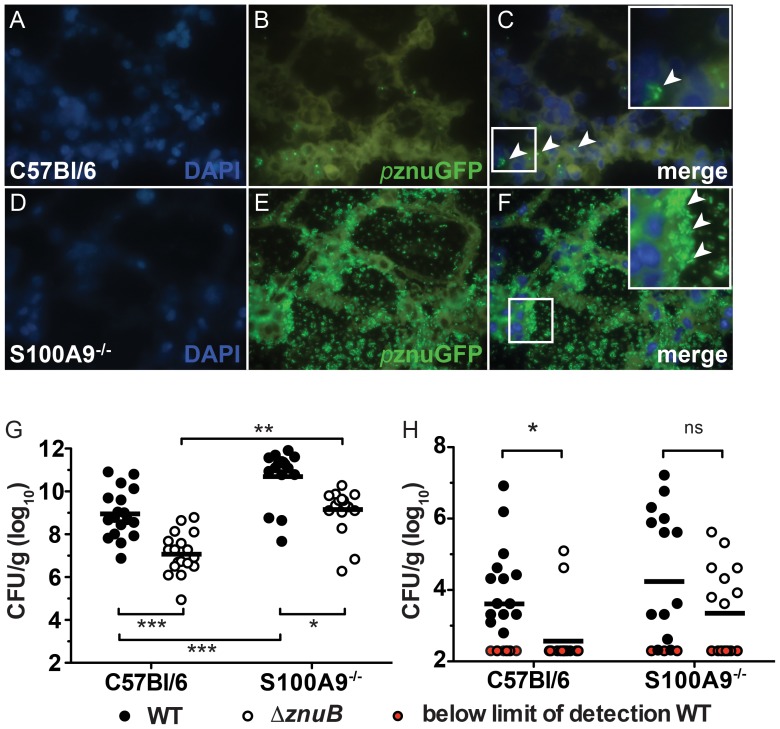
Contribution of the Znu system to pathogenesis in vivo.(A–F) In vivo GFP expression driven by the znu promoter. Frozen sections of lungs harvested at 36 hpi from wildtype (A–C) or S100A9−/− (D–F) mice infected with WT::pznuGFP and stained with DAPI. Arrowheads in the merged images indicate bacteria expressing GFP. (G–H) Competition infection between wildtype and ΔznuB. Bacterial burden in lungs (G) and livers (H) of mice co-infected with wildtype A. baumannii and ΔznuB. Red symbols indicate CFU below the limit of detection. * p<0.05, ** p<0.01, *** p<0.001 as determined by one-way ANOVA.